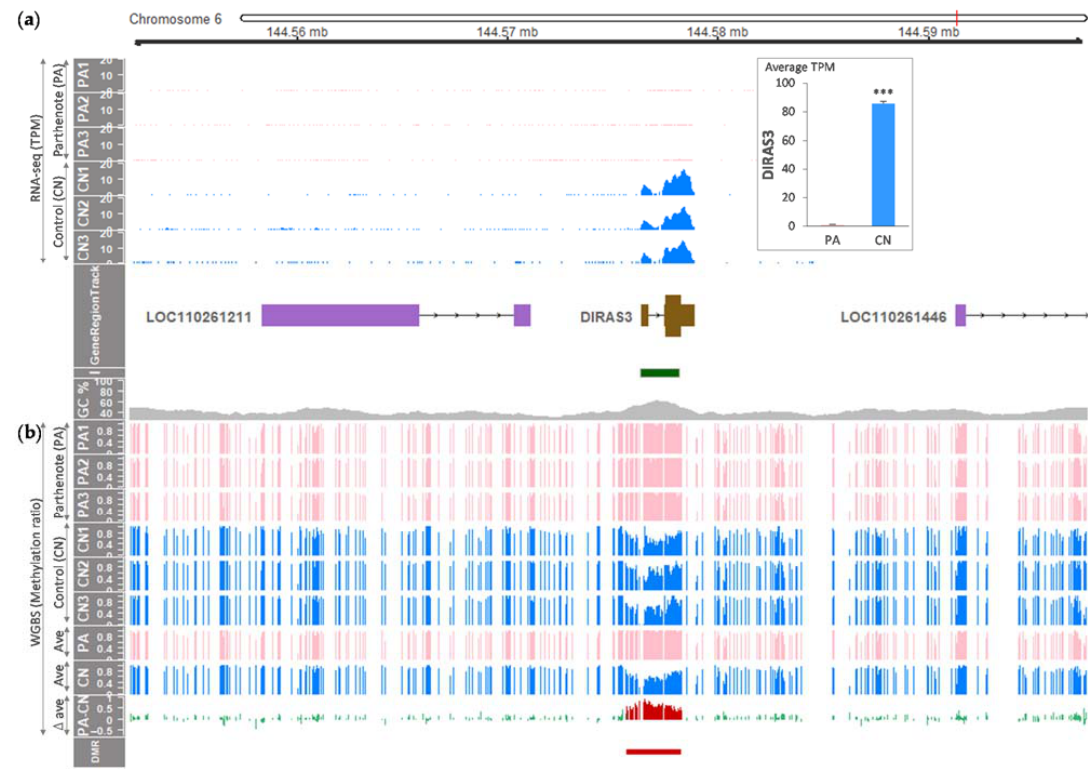
Figure 1. Profiling of the transcriptome and DNA methylome from the porcine parthenotes (PAs) and control embryos (CNs). ( a ) RNA-seq read coverages were normalized to transcripts per million (TPM). Differential expression (DE) of the porcine DIRAS3 gene between PA and CN ( n = 3 each) is shown in the box in the top-right corner (mean ± SEM; ***, adjusted p < 0.05). In GeneRegionTrack, purple boxes indicate exons of noncoding genes, and a protein-coding gene is shown as brown boxes with tall and short boxes indicating translated and untranslated regions, respectively. The direction of transcription is marked by horizontal arrows. I, CpG islands; GC % , GC content in percent. ( b ) CG methylation ratios of triplicates of PA and CN derived from whole-genome bisulfite sequencing (WGBS) are displayed, and averaged ratios were used to obtain differences in ratios ( ∆ ave, delta average). A differentially methylated region (DMR) between PA and CN (FDR < 0.05) is indicated with a red bar and overlaid on differentially methylated CGs in the PA-CN track with red histogram